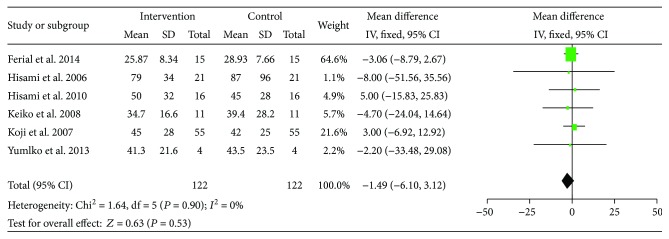
Forest plot for ALT.